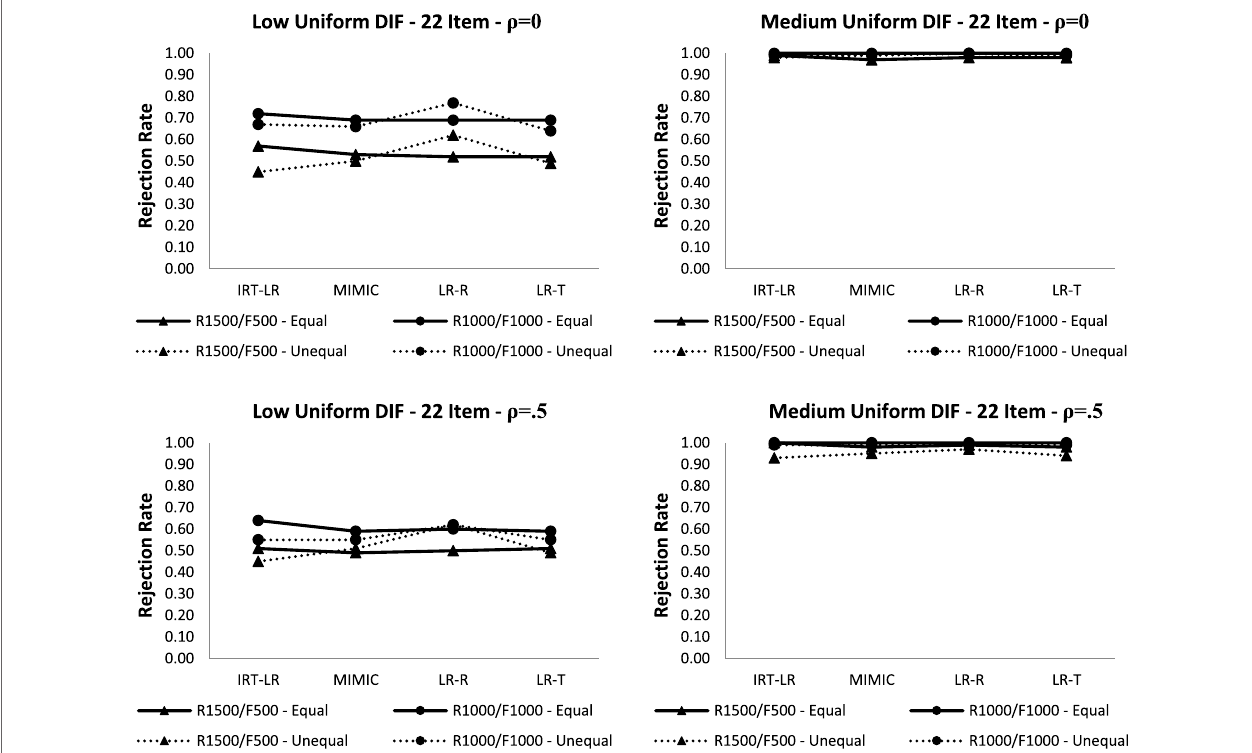
FIGURe 2 | Rejection rates for uniform differential item functioning (DIF) with equal and unequal latent means between focal and reference groups in the 22-item test ( note : LR-R is logistic regression with raw scores; LR-T is logistic regression with latent trait scores).